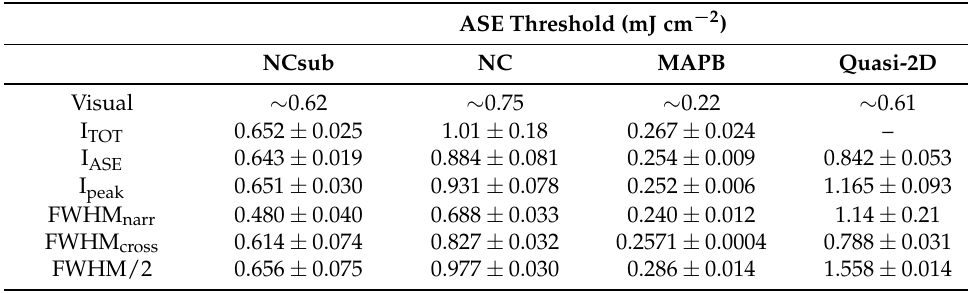
Table 1. ASE threshold values obtained from the application of all the methods for the perovskite samples. ASE Threshold (mJ cm − 2 ) NCsub NC MAPB Quasi-2D Visual ∼ 0.62 ∼ 0.75 ∼ 0.22 ∼ 0.61 I TOT 0.652 ± 0.025 1.01 ± 0.18 0.267 ± 0.024 – I ASE 0.643 ± 0.019 0.884 ± 0.081 0.254 ±